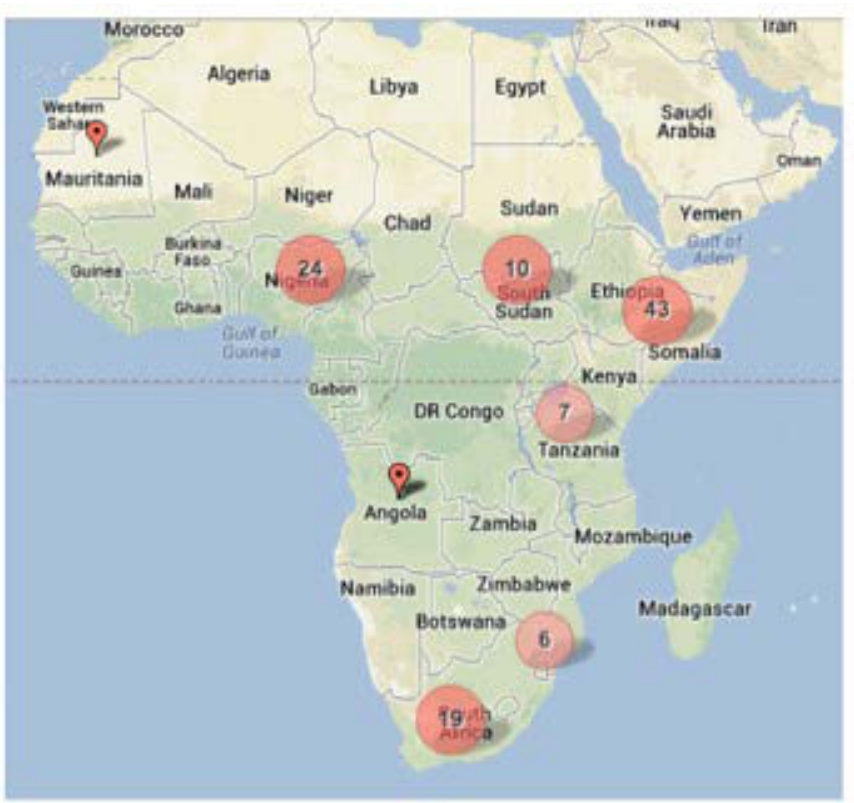
Figure 4: Regional geographic clustering of terrorist groups with an identified web